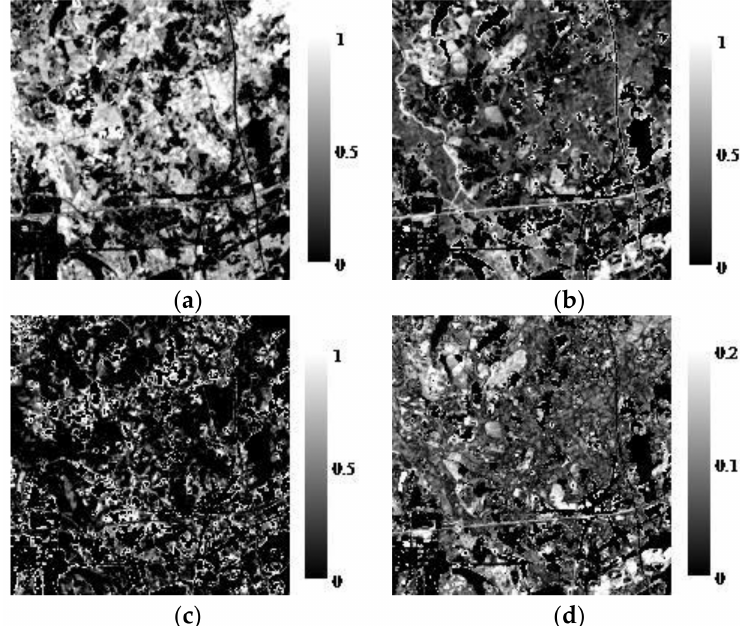
Figure 8. Abundance distribution of three crop types and the RMSE of mixed pixel decomposition. ( a ) The abundance in each pixel in double cropping rice; ( b ) the abundance in each pixel in peanut/sweet potatoes; ( c ) the abundance in each pixel in orange groves; ( d ) the RMSE of mixed pixel